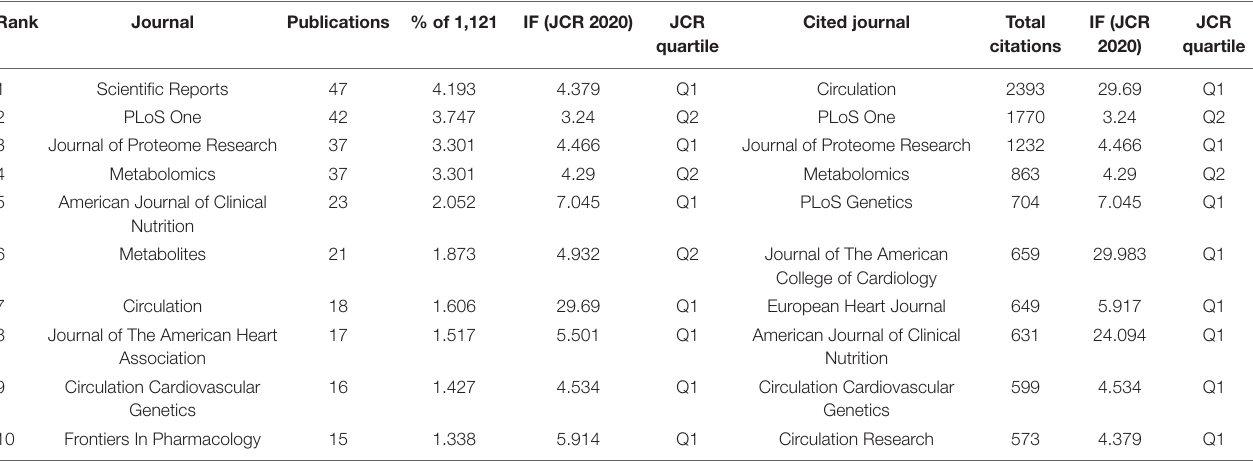
FIGURE 3 | VOSviewer visualisation map of co-operation and co-citation of authors related to coronary artery disease and metabolome research. (A) The co-operation of network of authors. Different colours represent clusters of close cooperation. The thickness of the lines indicates the strength of the relationship. (B) Co-citation network of authors. Shah SH had the highest number of co-citations. TABLE 4 | Top 10 journals distributed by publications and